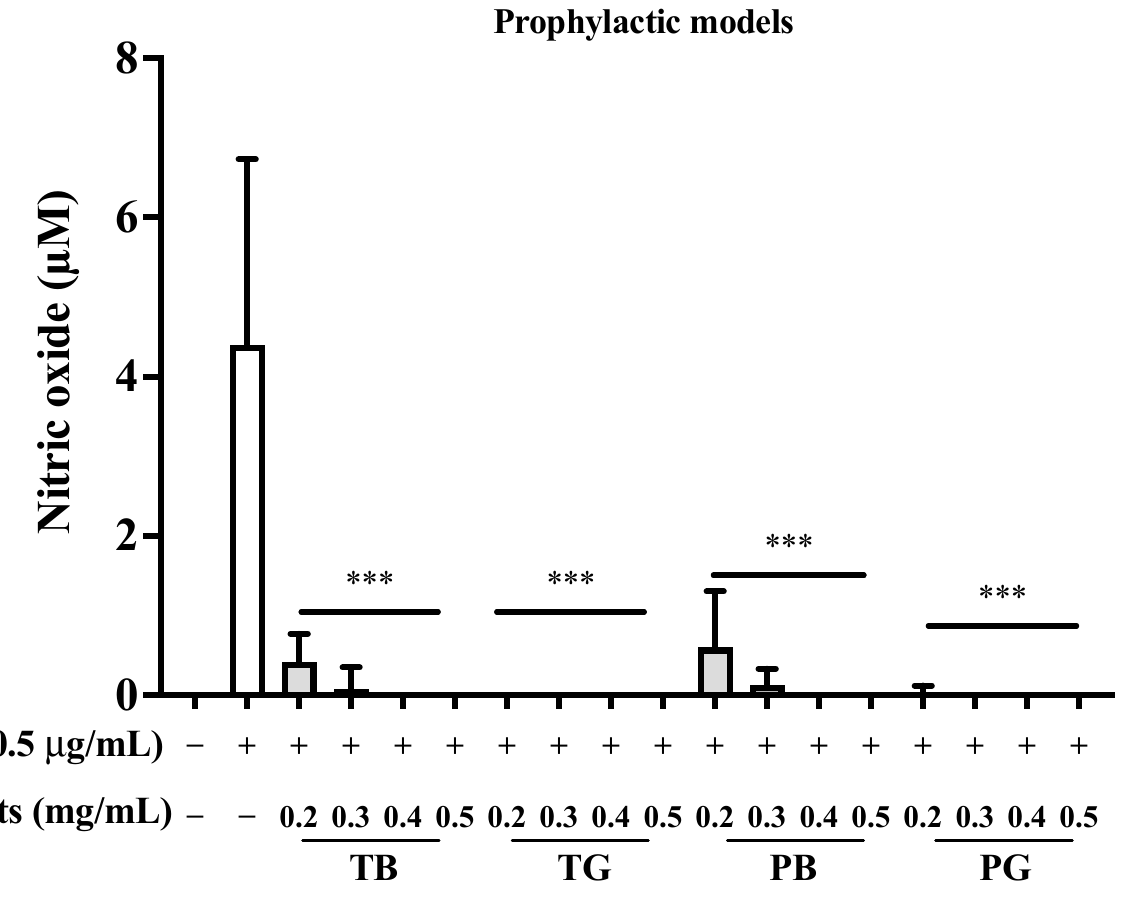
Figure 5. Effects of various concentrations of tea pretreatments on nitric oxide inhibition rates in LPS-stimulated macrophages as the prophylactic model. In our prophylactic model, the pretreatment of four tea extracts was performed for 8 h. Then LPS (0.5 μ g/mL) was added and co-incubated for the remaining 16 h to explore the prophylaxis of the four teas. The data were presented as mean ± SE of three experiments. *** p < 0.001. LPS: Lipopolysaccharide. T: Taiwan Tea Experiment Station No. 12; P: purple shoot tea; G: green tea and B: black tea.